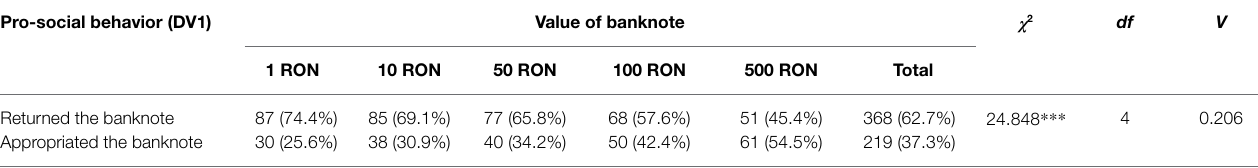
TABLE 1 | Cross-tabulation of values of the “lost” banknote and pro-social behavior toward the first confederate ( N = 587). Pro-social behavior (DV1) Value of